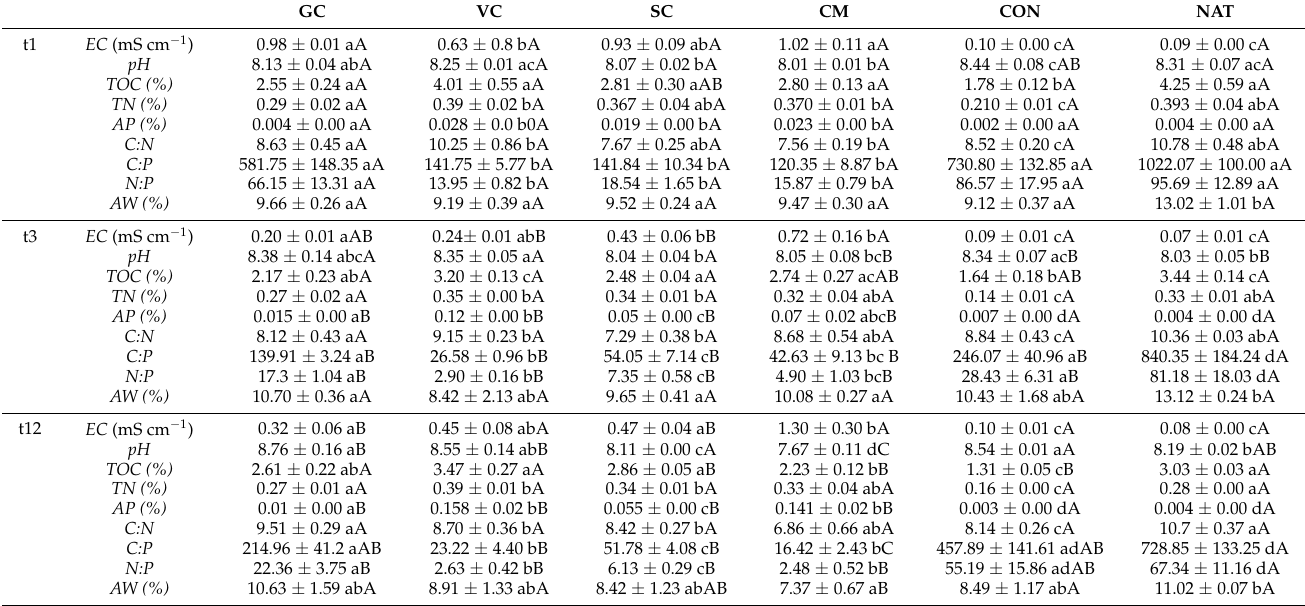
Table 1. Soil physico-chemical properties and main nutrient ratios of newly reclaimed abandoned agricultural soils with incorporation of different organic